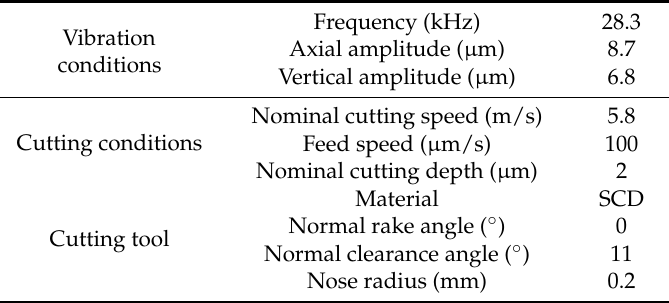
Figure 8. Application of the elliptical vibration cutting for surface topography cutting. ( a ) Schematic of elliptical vibration cutting for rapid fabrication of microdimple array. ( b ) The machined surface measured using a Zygo white-light interferometer. Table 1. Turning parameters.